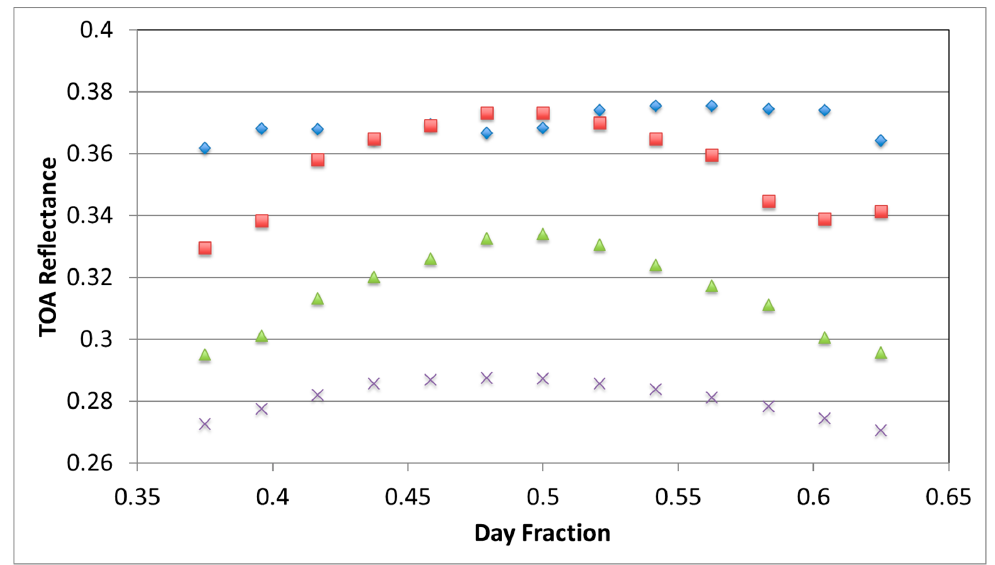
Figure 3. Predicted TOA reflectance from one of the current sites for four randomly selected dates showing the variability in TOA reflectance during the day. The variation over a 30 min time period is typically < 5% and is typically smaller for the overpass times of most sun-synchronous imagers. Simplistic approaches such as using the closest data point in time or linear interpolation are su ffi cient for most applications to ensure that the temporal variation in TOA reflectance is not the dominant uncertainty source. Applications using times of day for which the solar illumination angle changes significantly over time may necessitate more sophisticated approaches, depending upon the user’s uncertainty